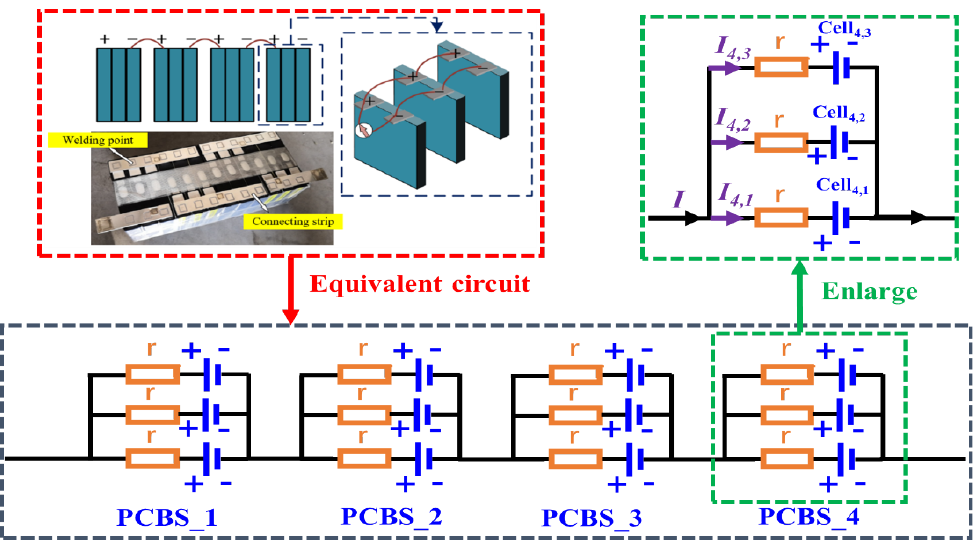
Figure 5. Equivalent circuit of the 3P4S pack.